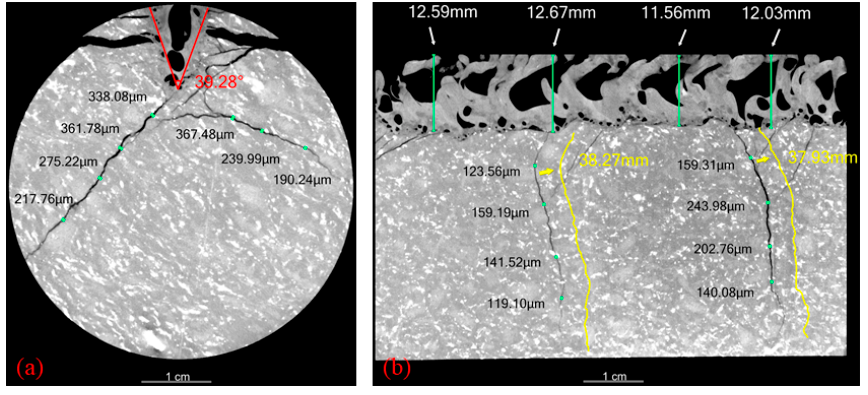
Figure 13. Interior-crack length and width at ( a ) starting point and ( b ) axial